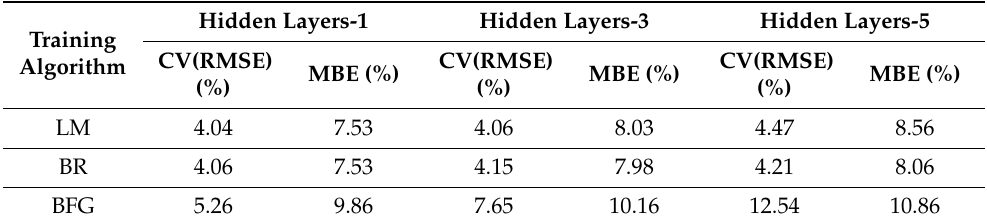
Table 3. CV(RMSE) and MBE of CO 2 Concentration Prediction